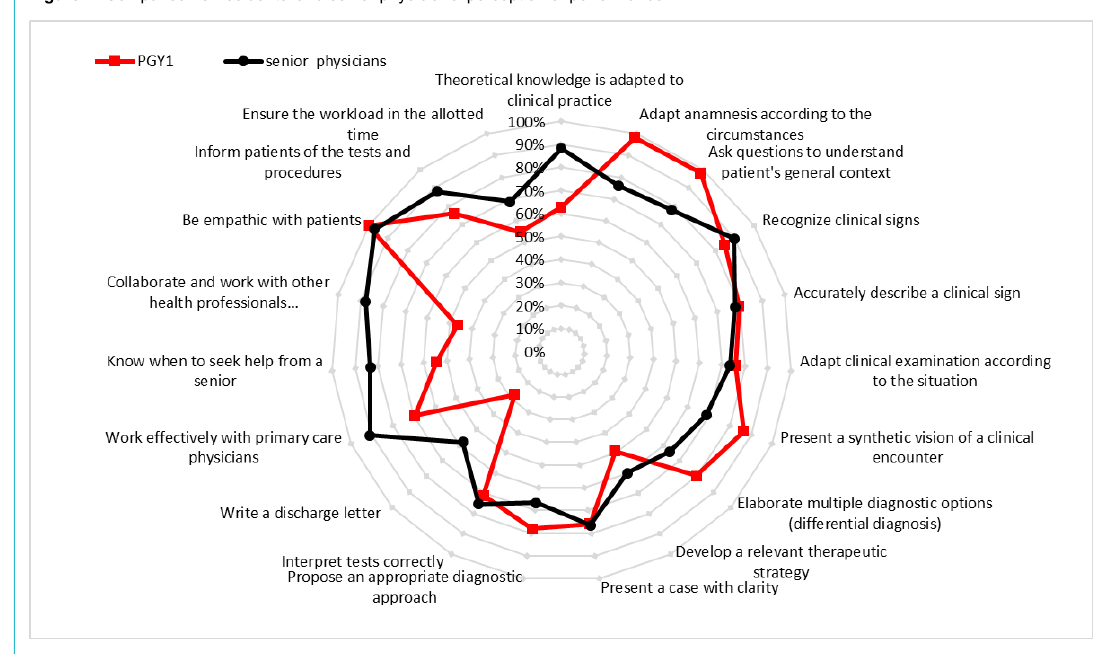
Figure 1: Comparison of residents’ and senior physicians’ perception of performance.